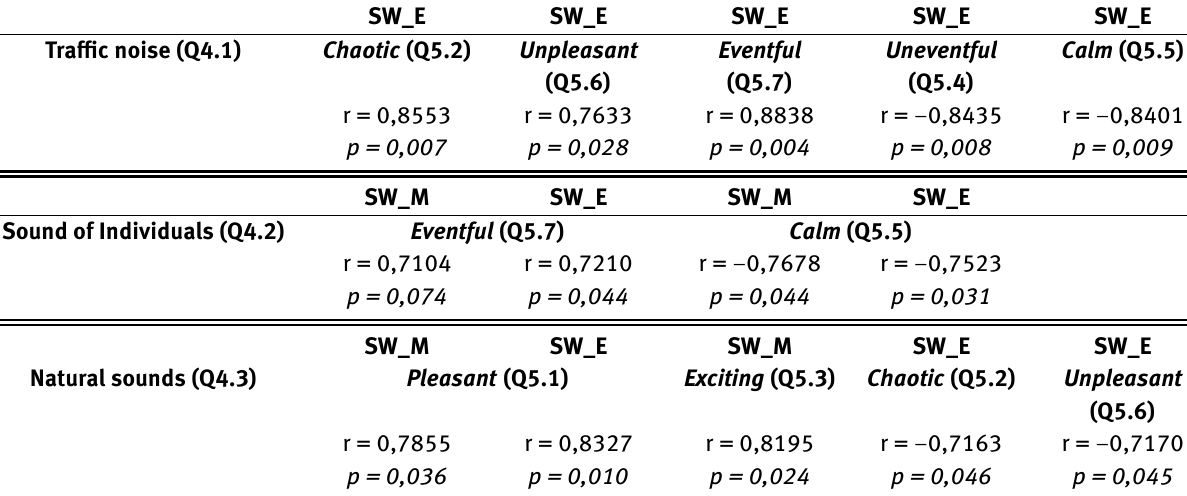
Table 6: Best correlation results for selected sound dominance (Q4) and perceived affective quality (Q5) components during morning and evening soundwalks